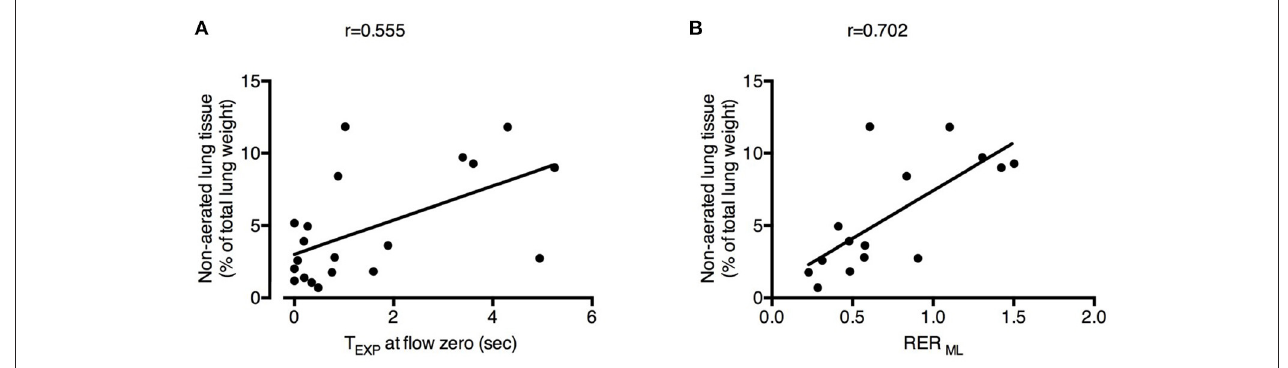
FIGURE 4 | Physiological changes induced by decreased respiratory rate and increased extracorporeal CO 2 removal associated with the development of atelectasis. Increased expiratory time spent at zero flow (T EXP at flow zero) (A) and higher Respiratory Exchange Ratio of the membrane lung (RER ML) (B) were correlated with higher fraction of non-aerated lung tissue (i.e., atelectasis). See text for methodological details. Number of observations were n = 20 in (A) due to unavailability of calculation of expiratory time at flow zero in one of the animals and n = 15 in (B) due to impossibility of blood withdrawal to calculate RER ML in one of the animals.